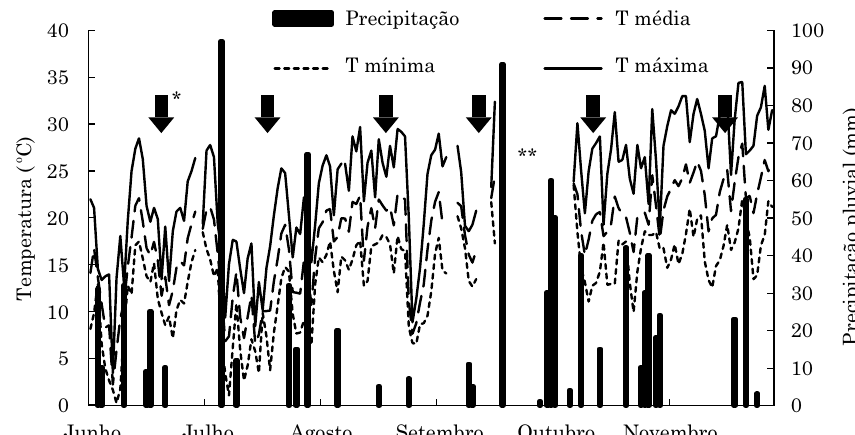
Figura 1. Precipitação pluvial, temperatura média (T média), temperatura mínima (T mínima) e temperatura máxima (t máxima), de três Passos, rs, referentes ao período de junho a novembro de 2012, obtidas da Estação Meteorológica Automática de Santo Augusto, RS (Inmet, 2015). * As flechas indicam o momento da aplicação dos dejetos líquidos de suínos na área experimental. **Período em que não houve o registro de dados pela estação